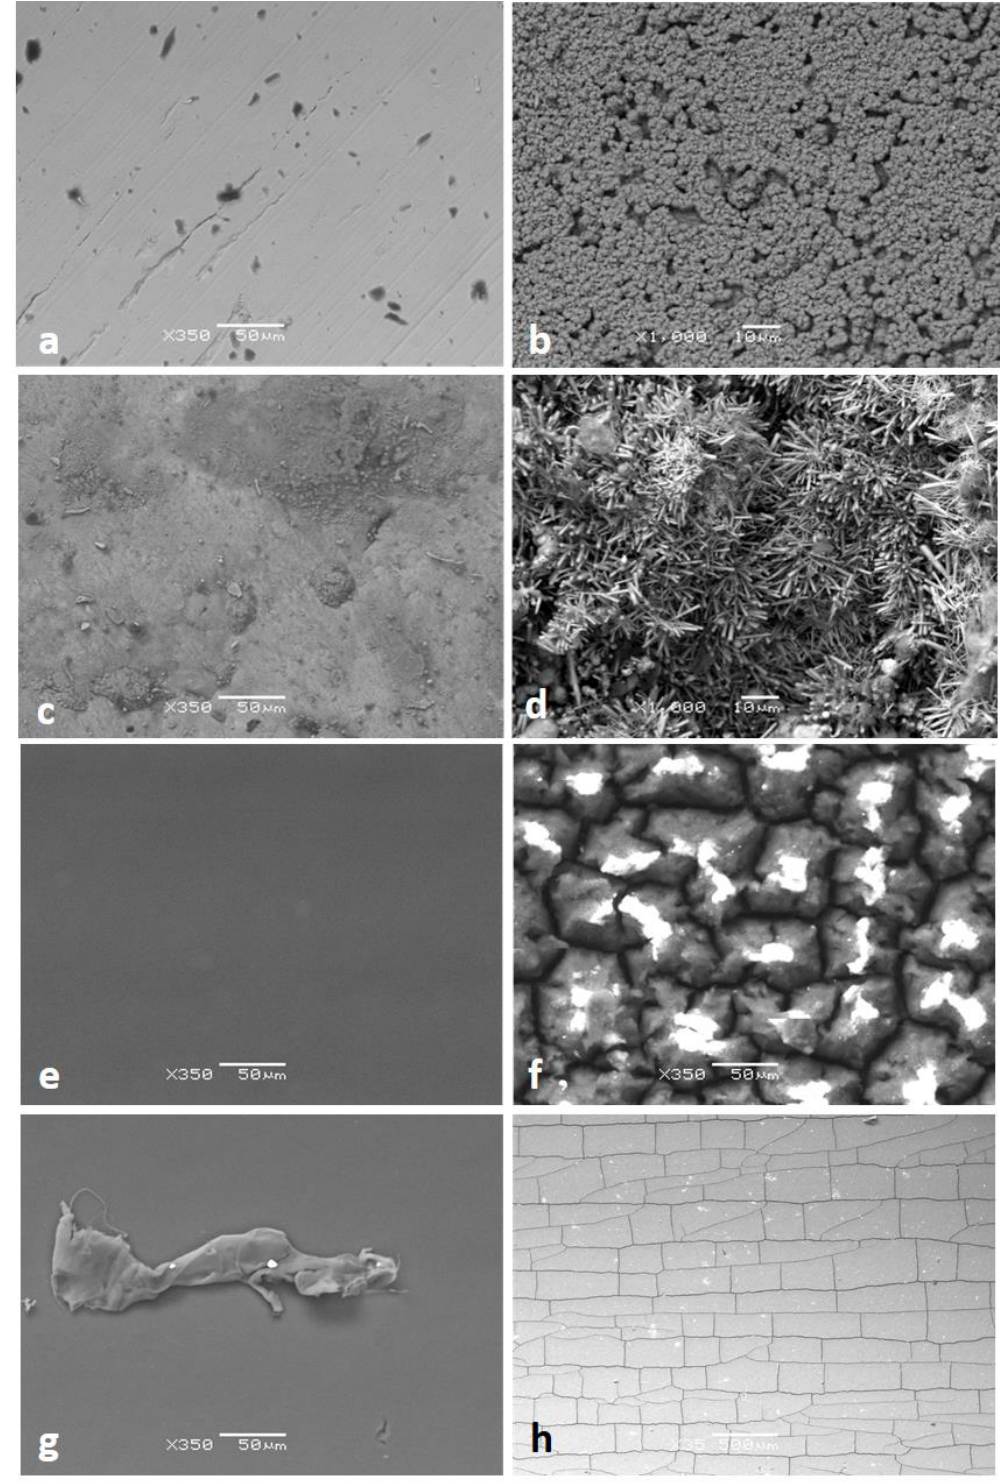
Figure 3. Cu pipe—new (350X) (a) , Cu pipe—8 weeks (1000X) (b) , galvanized steel—new (350X) (c) , galvanized steel—8 weeks (1000X) (d) , random polypropylene (PPR)—new (350X) (e) , PPR—8 weeks (350X) (f) , polyethylene of raised temperature (PERT)—new (350X) (g) , and PERT—8 weeks (350X) (h) .